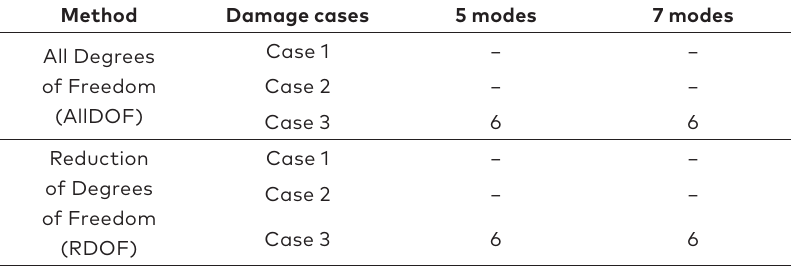
Table 6. False elements identified for the 31-element truss without noise